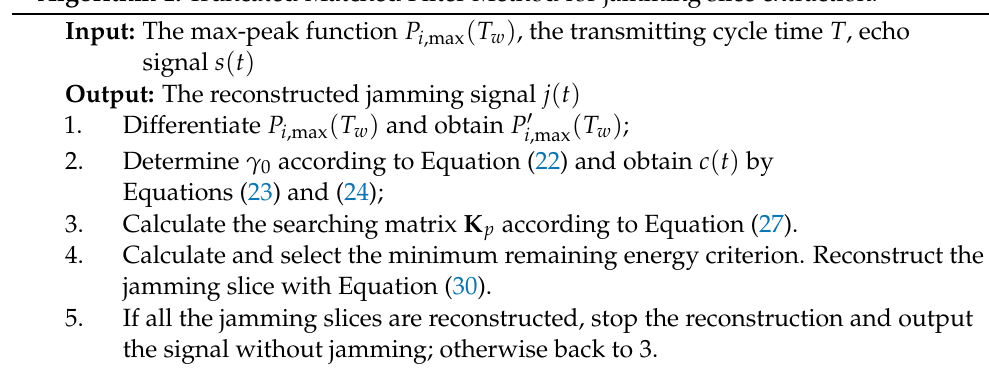
Algorithm 1: Truncated Matched Filter Method for jamming slice